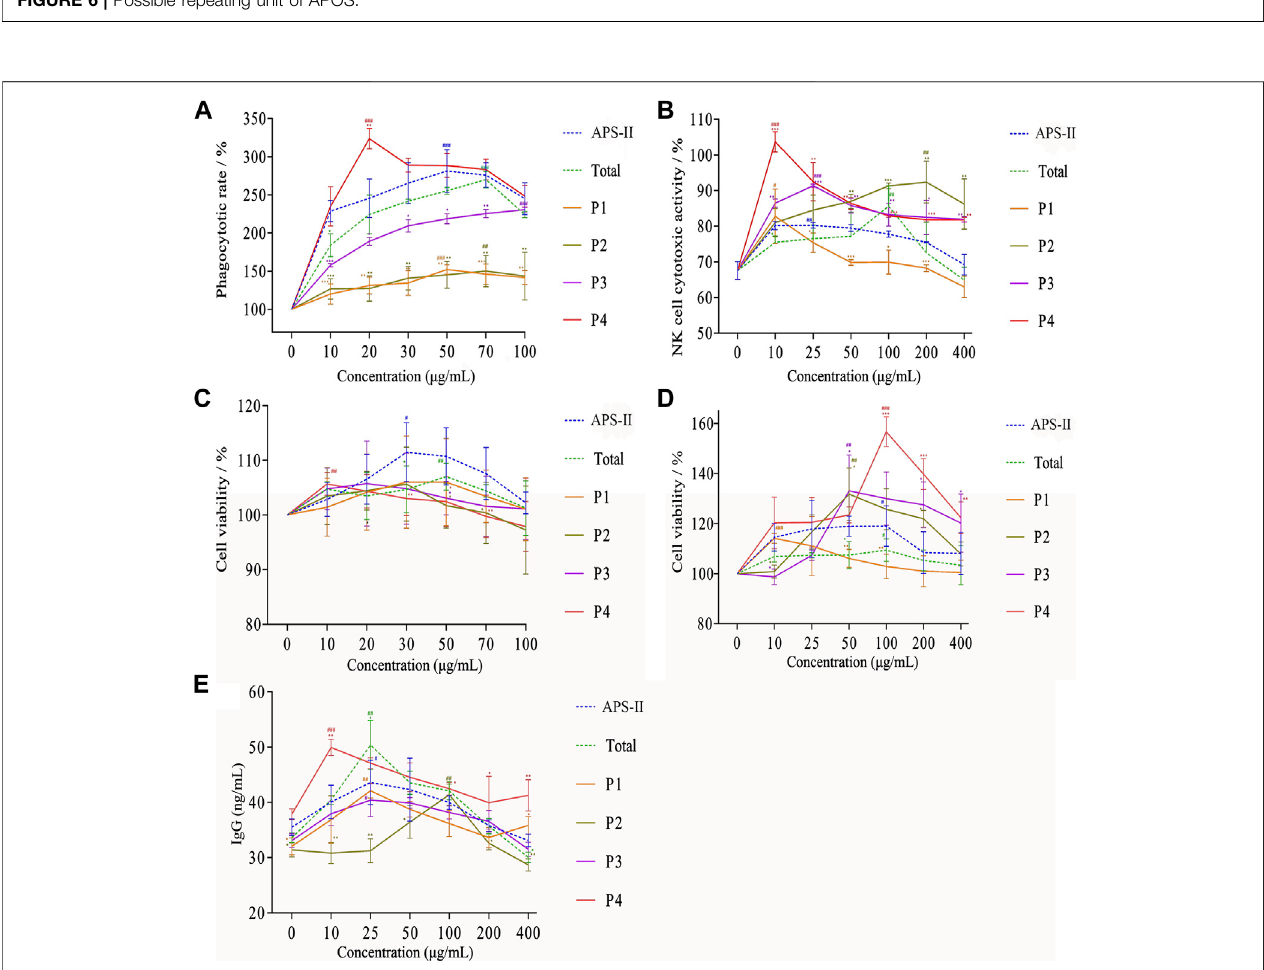
FIGURE 7 | Effects of different saccharide components on phagocytic activity (A) , killing activity of mouse spleen NK cells (B) , proliferation of B lymphocytes (C) , proliferation of T lymphocytes (D) , and IgG secretion of splenic lymphocytes (E) ( n = 6, * p < 0.05, ** p < 0.01, *** p < 0.001 versus APS-II; # p < 0.05, ## p < 0.01, ### p < 0.001 versus blank control